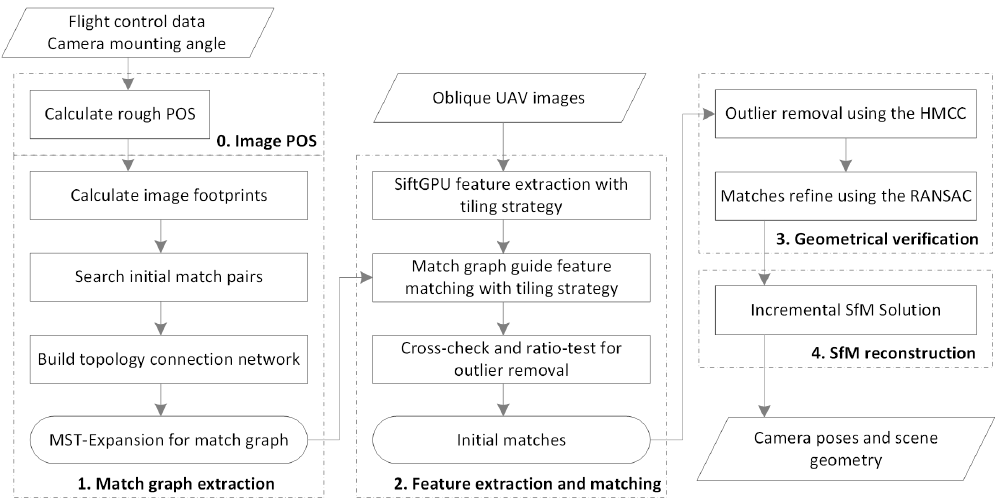
Figure 5. Integrated solution for efficient SfM of oblique UAV